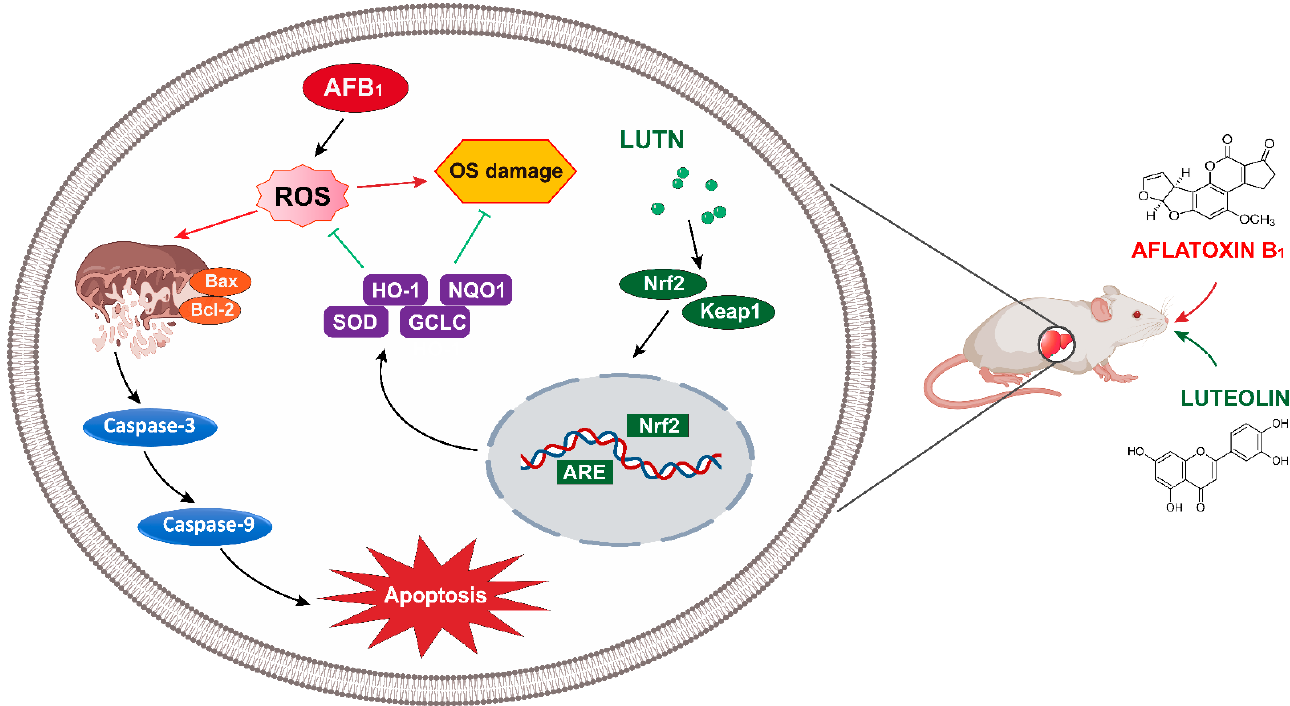
Figure 8. Schematic diagram representing hepatoprotective mechanism of luteolin against AFB 1 -induced apoptosis and oxidative stress via the activation of Nrf2 signaling pathway in the liver of mice.